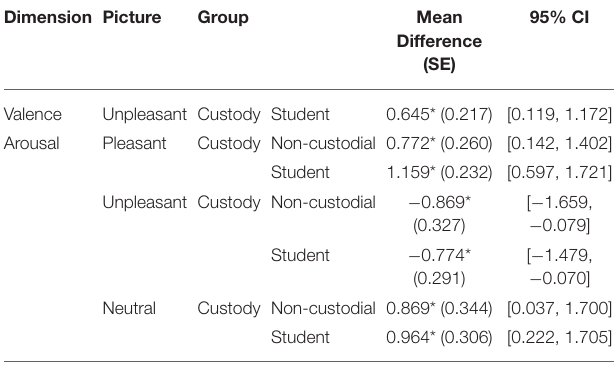
TABLE 2 | Post-hoc pairwise comparisons according to